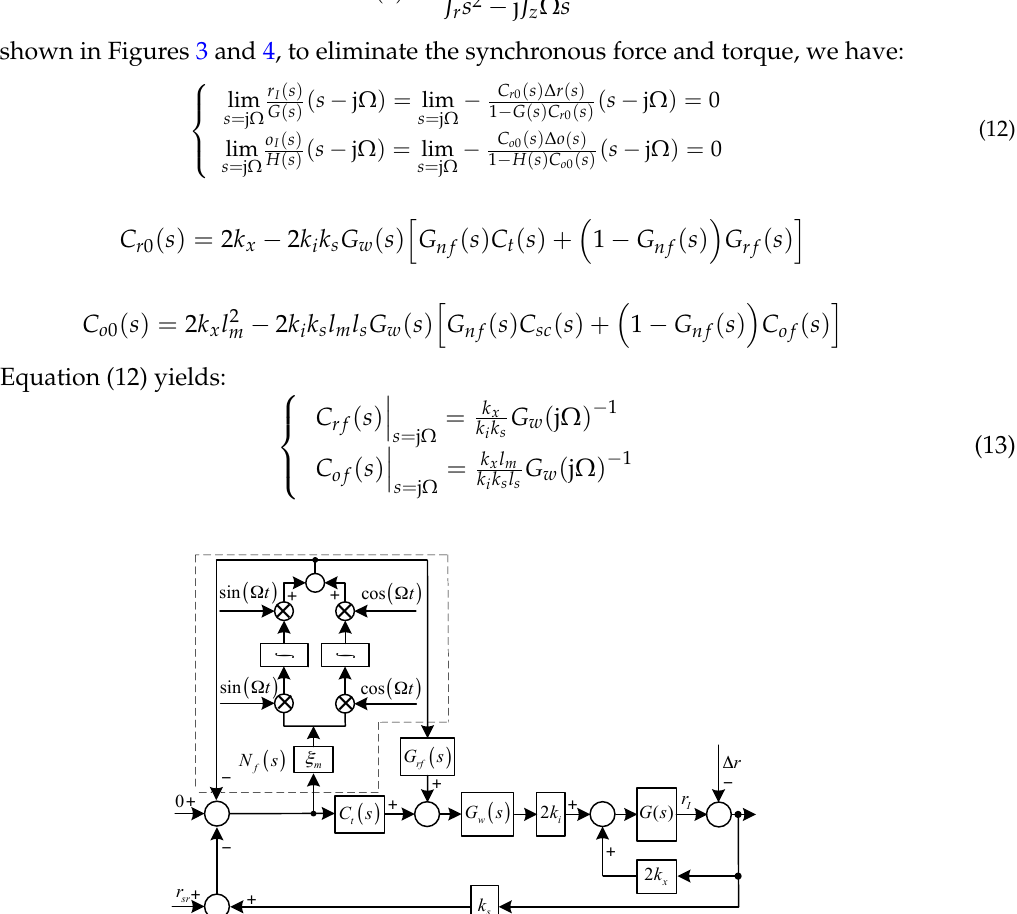
Figure 3. Diagram of the translational system with synchronous force elimination.